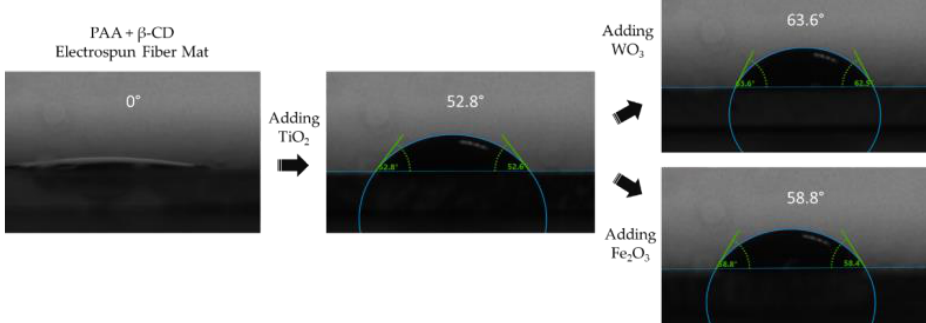
Figure 3. Water contact angle images for the analyzed samples.